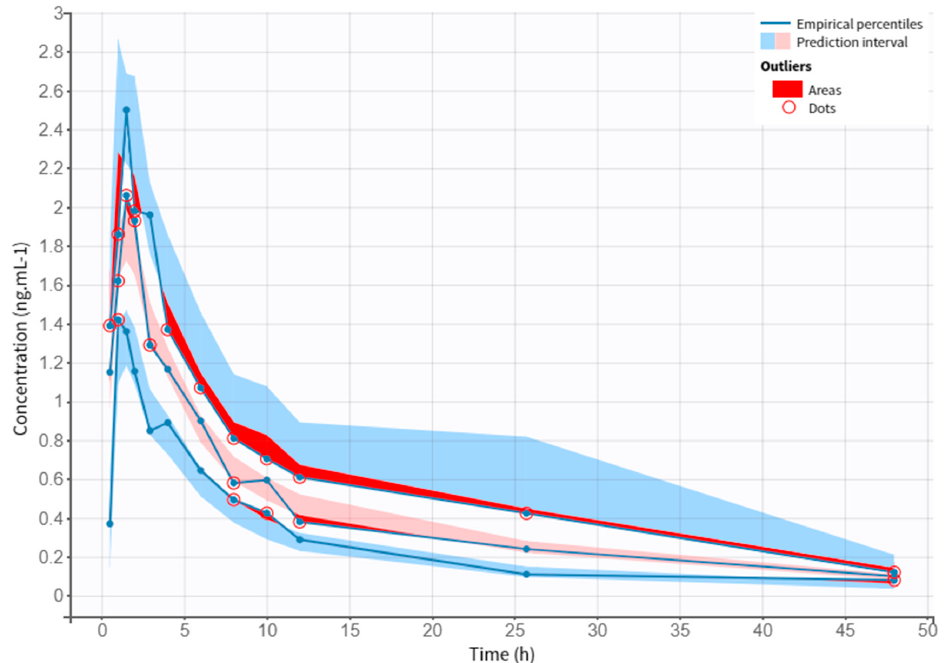
Figure 5. Visual Predictive Check (VPC) plot versus time using the final covariate pharmacokinetic model. The figure displays the VPC with the prediction intervals for the 10th, 50th, and 90th percentiles (from bottom to top, respectively). Outliers are visualized as red dots and